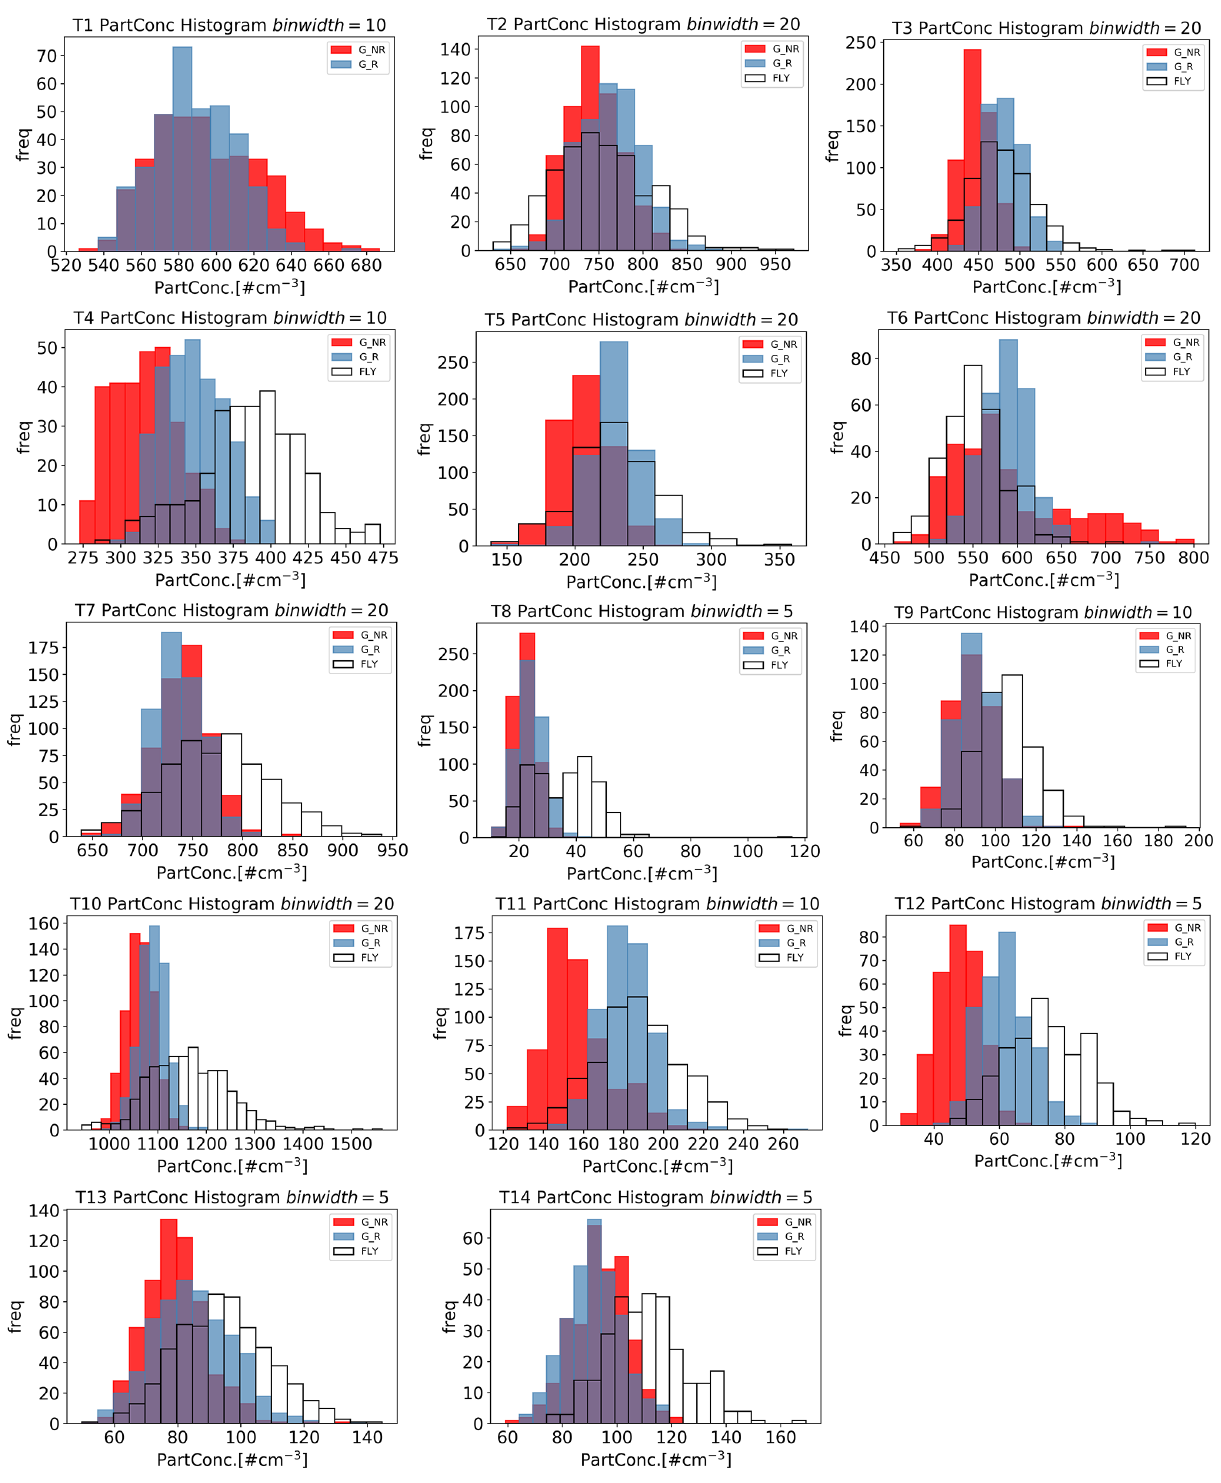
Figure 4. Probability density functions (PDFs) of PNCs in each case. A constant bin width is utilized across the G_NR, G_R, and FLY PDFs of each